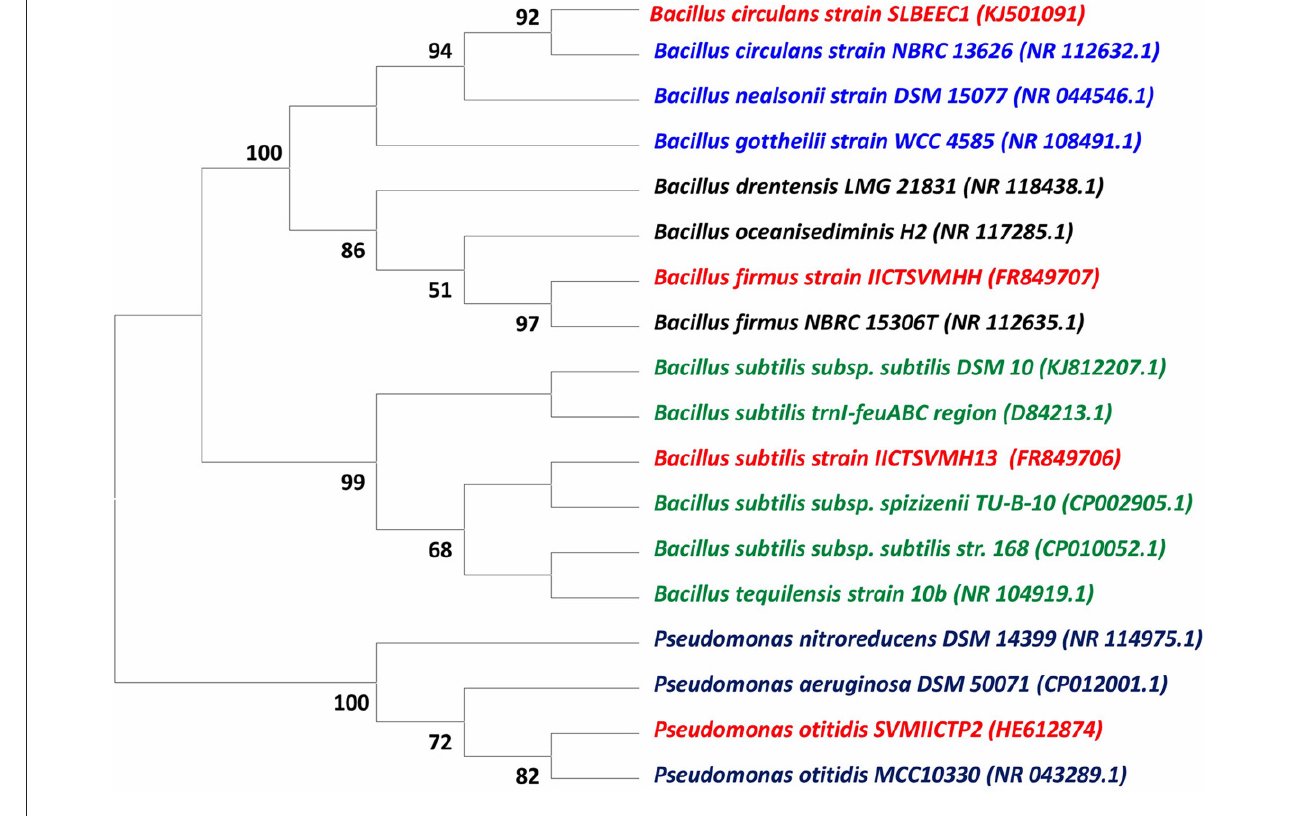
FIGURE 1 | Evolutionary relationship analysis of 16S rDNA sequence of wastewater treating Strains (Isolated strains are marked in red color).